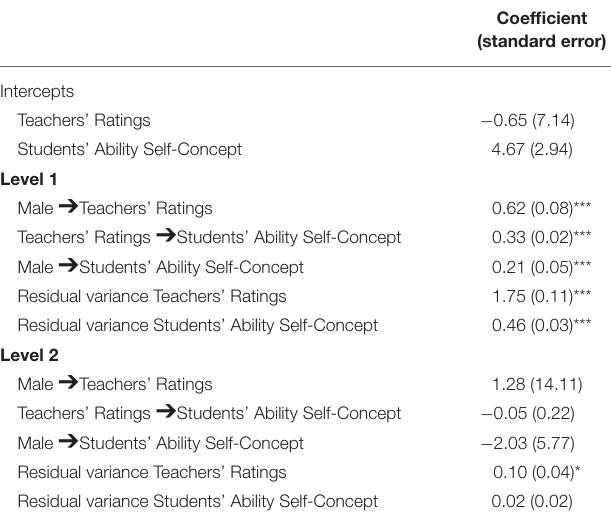
TABLE 4 | Mediation of the effect of gender on students’ math ability self-concept via teachers’ aptitude ratings.